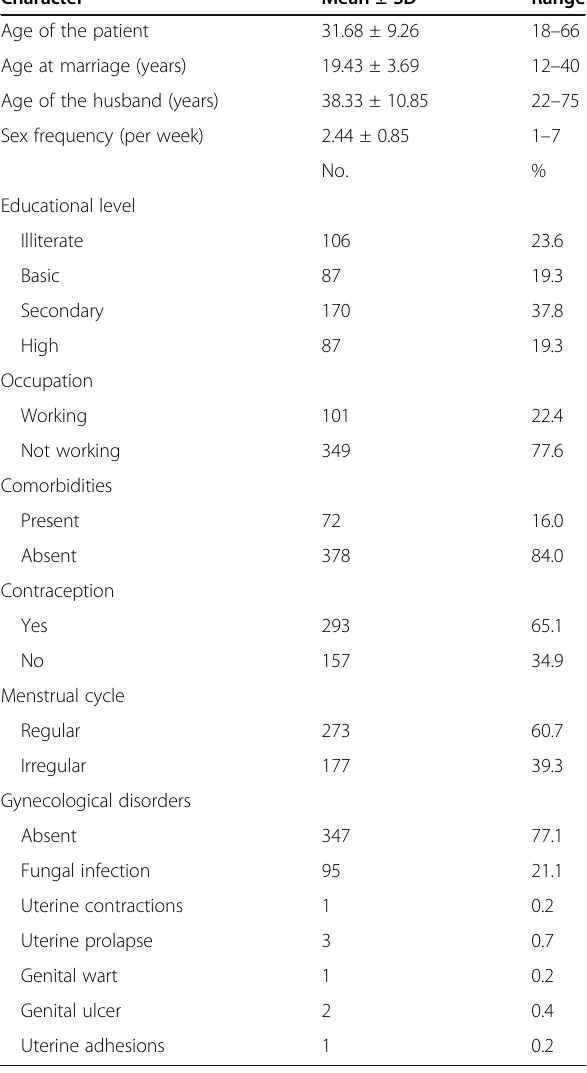
Table 1 Sociodemographic data of the studied group ( n =